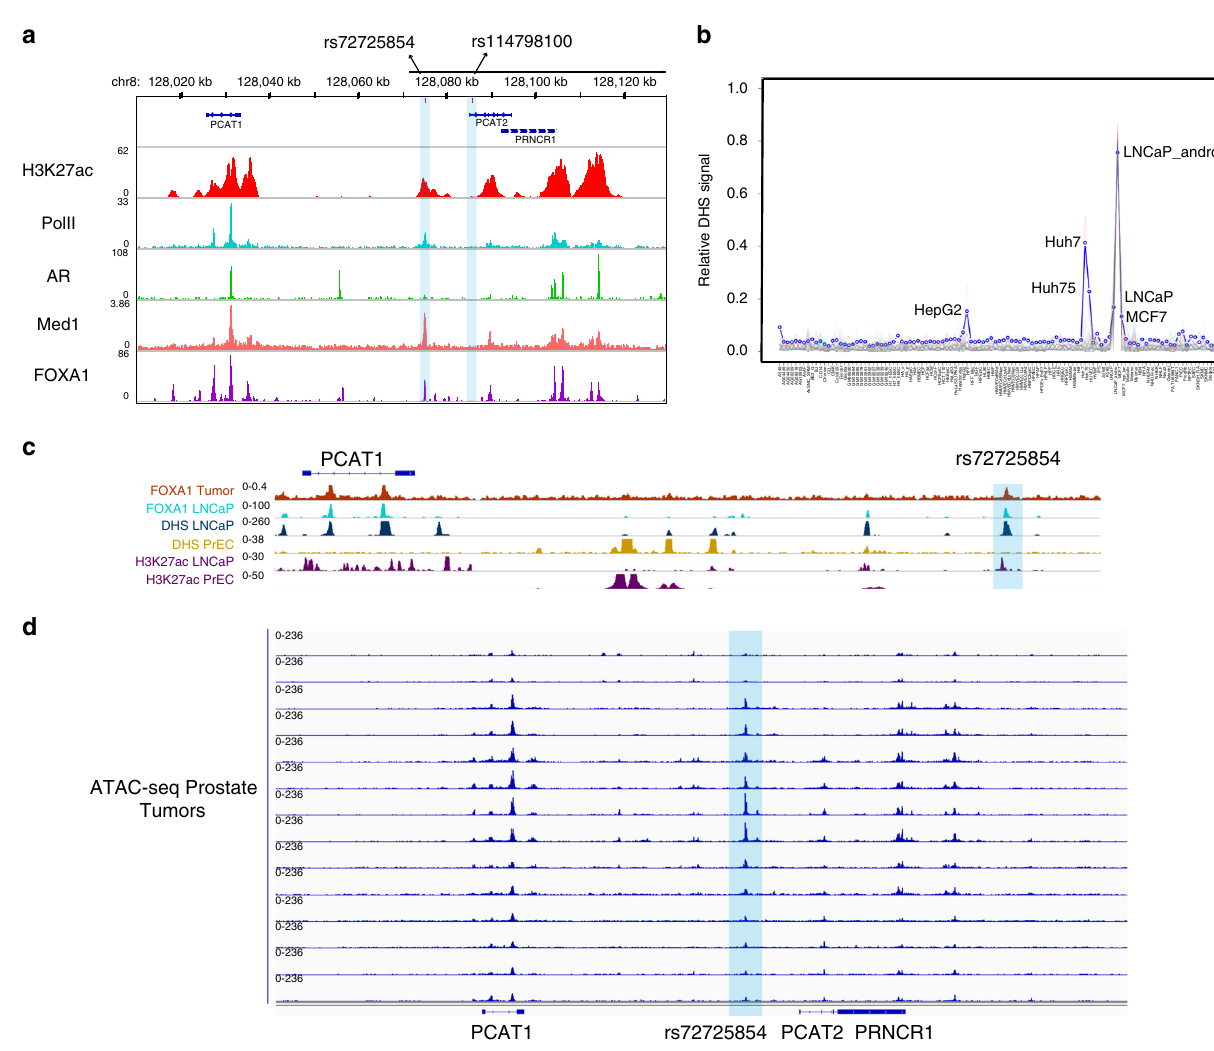
Fig. 1 rs72725854 lies in a prostate cancer-speci fi c enhancer. a UCSC genome browser snapshot at rs72725854 region and its linked SNP rs114798100 showing ChIP-seq tracks for H3K27Ac, PolII, AR, Med1, and FOXA1. b Graph showing DHS signal around the rs72725854 region in various cell lines. c Genome browser snapshots show ChIP-seq signal of FOXA1 in prostate tumor, LNCaP cells; DHS and H3K27ac in LNCaP and prostate epithelial cells (PrEC). d IGV genome browser snapshot shows ATAC-seq signal around rs72725854 region in seven prostate adenocarcinoma tumor samples with two replicates each from